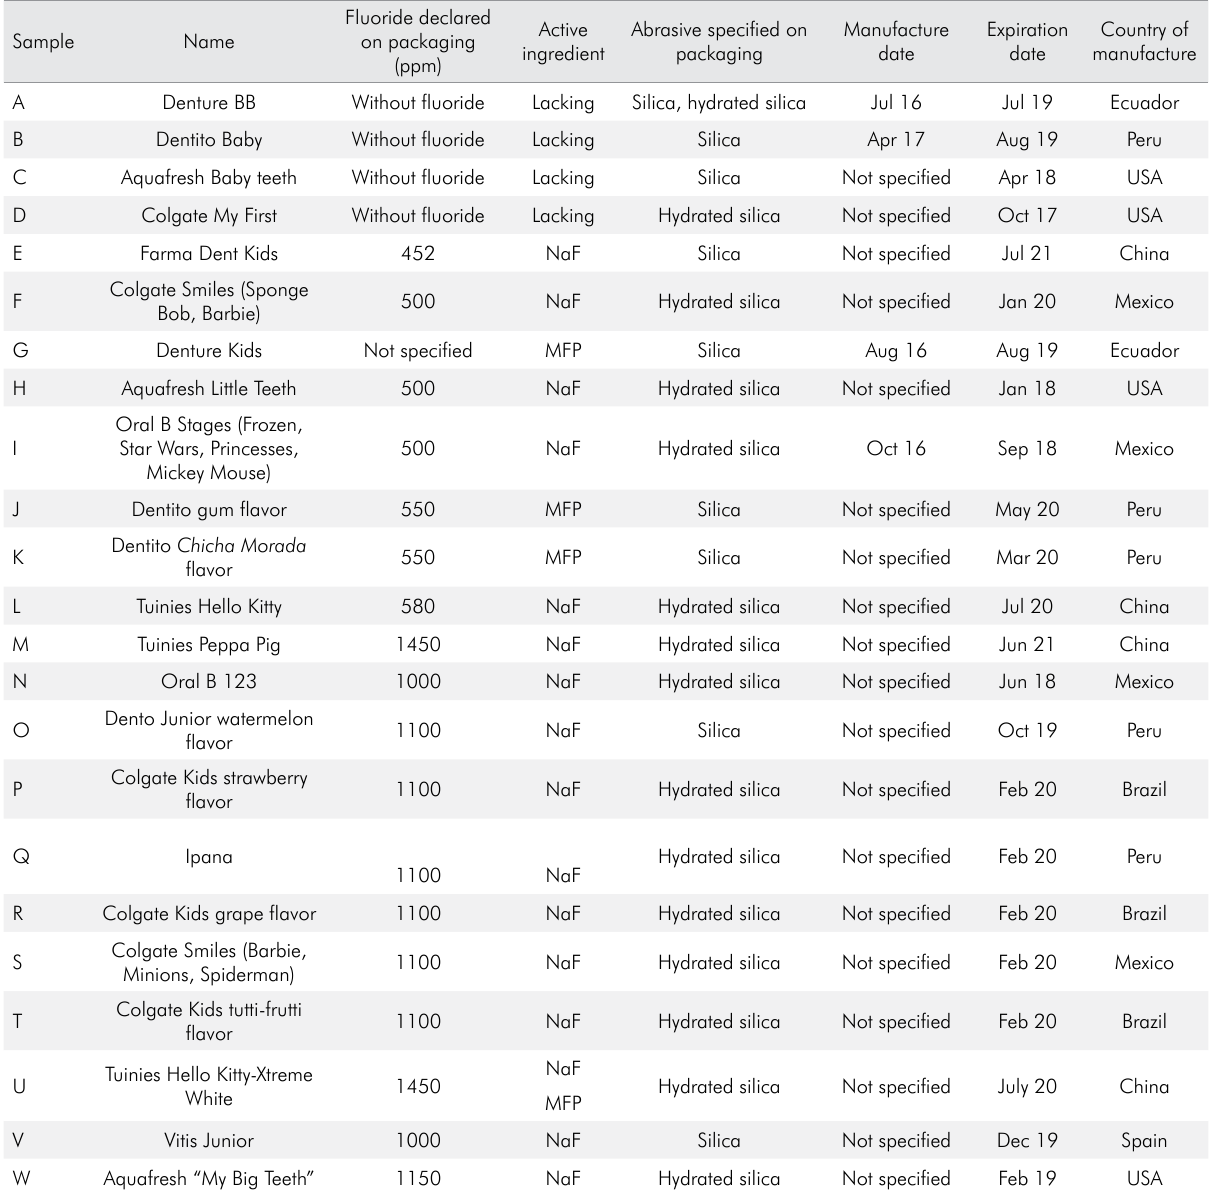
Table 1. Information regarding the dentifrices analyzed (Lima,